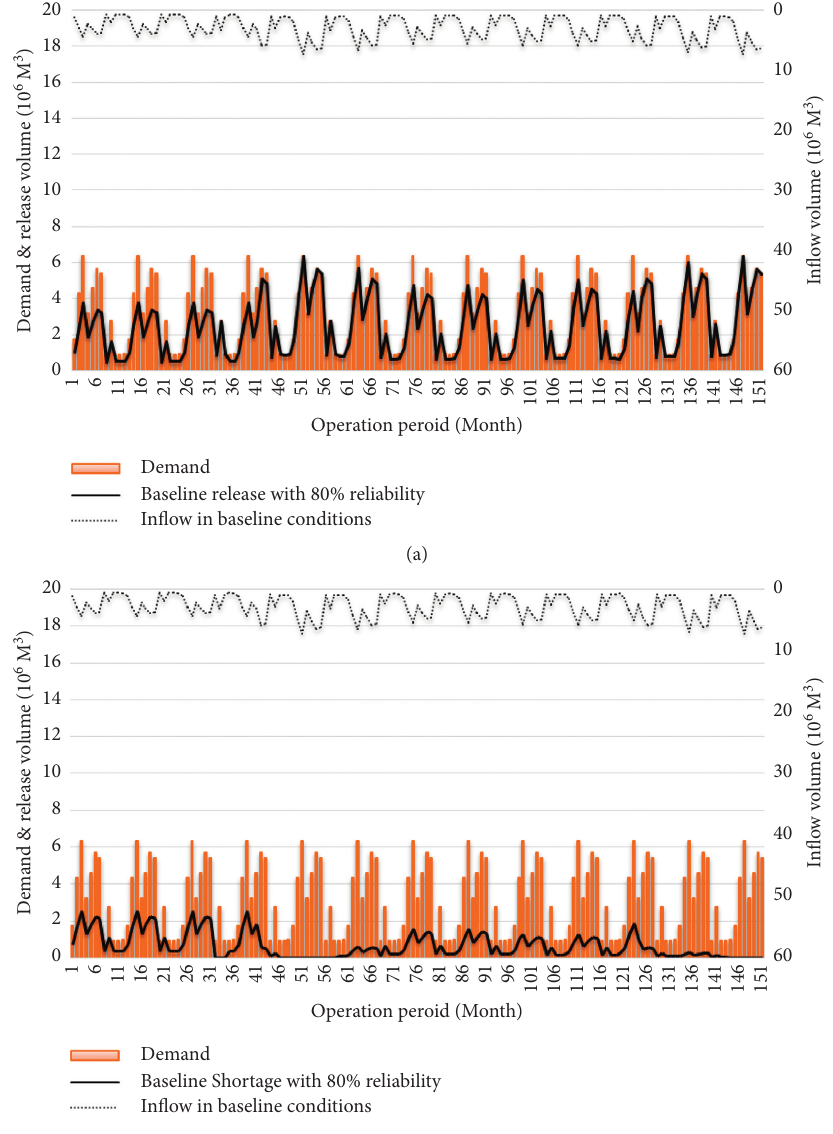
Figure 7: The comparison of (a) release volume (b) and shortage volume per each Pareto point resulted from 75% reliability in baseline